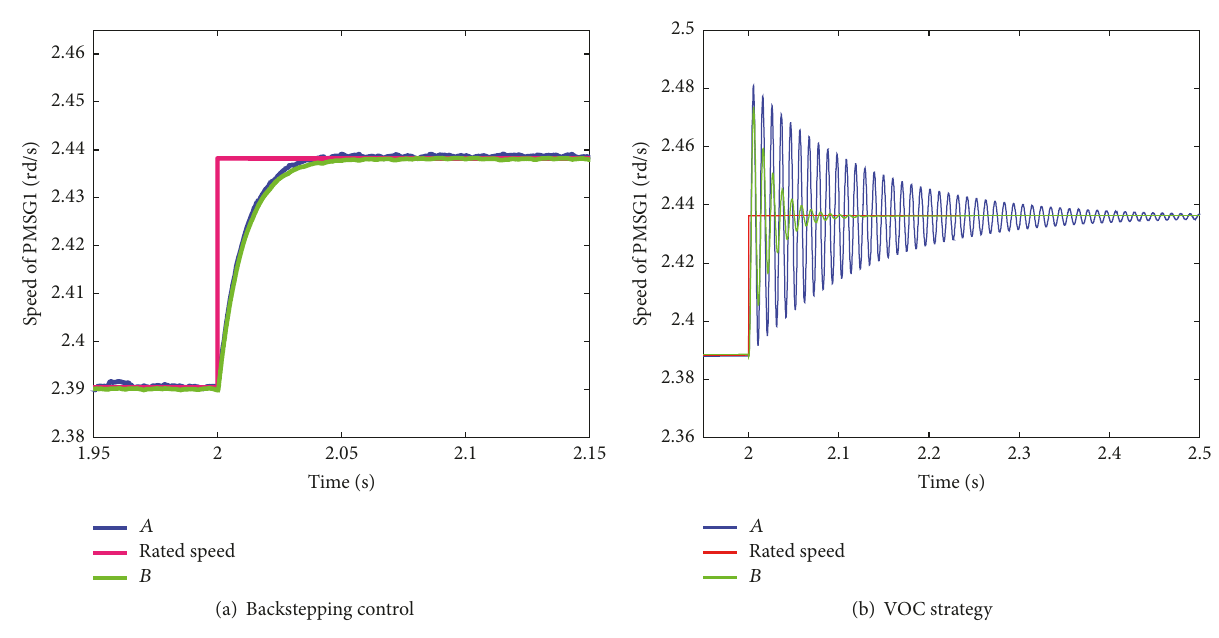
Figure 12: DDSG1 speed